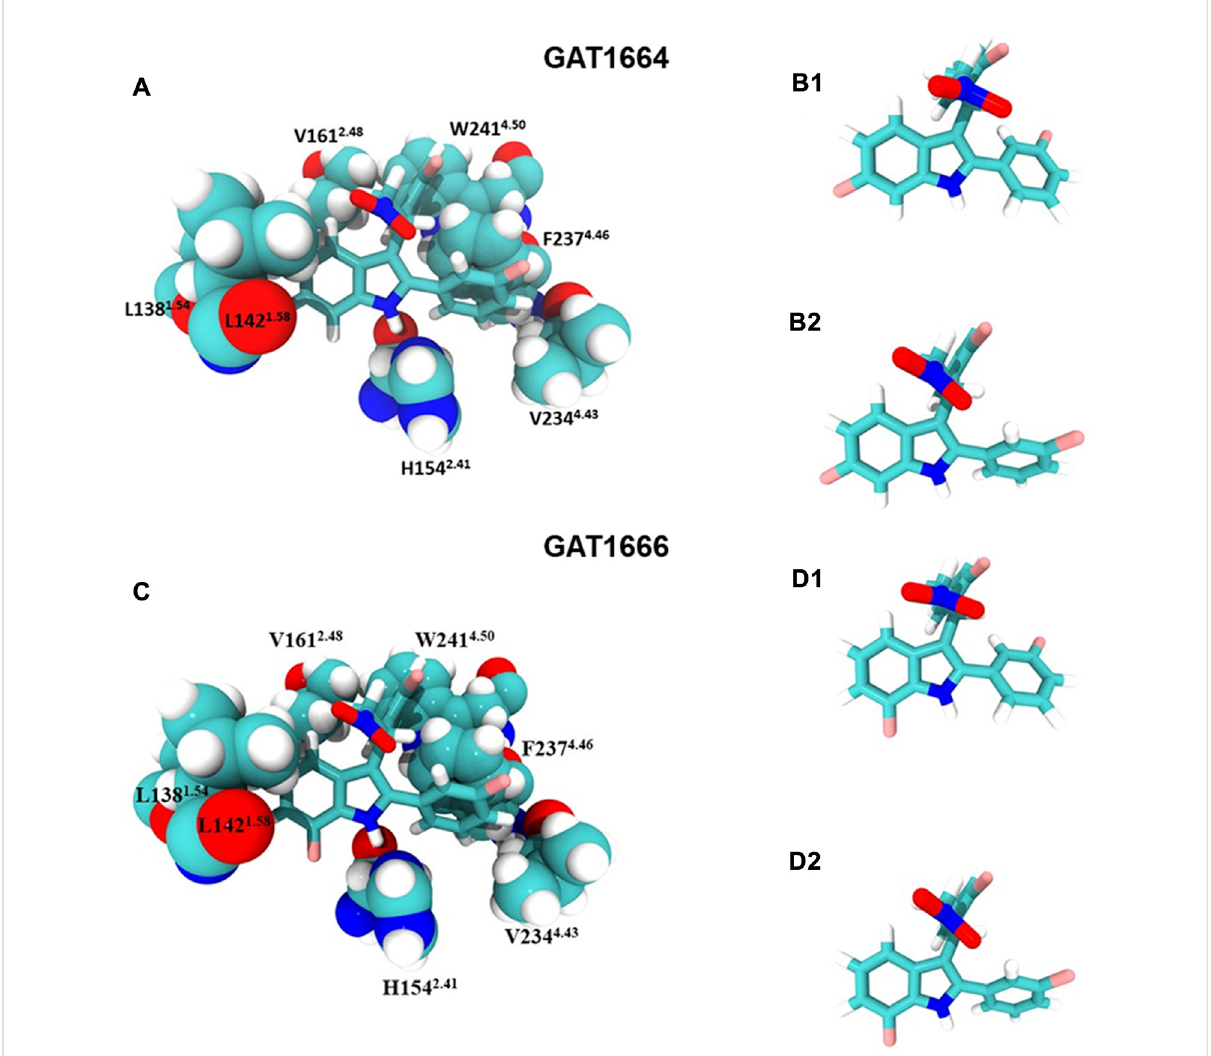
FIGURE 7 GAT1664 and GAT1666 bind to a putative allosteric agonist site. (A) GAT1664 main interactions and the amino acid residues of the binding pocket displayedin tanin Figure 6.The conformation ofGAT1664before itbinds to hCB1R (B1) and then theconformationof GAT1664.afterit binds to hCB1R (B2) . (C) GAT1666 main interactions and the amino acid residues of the binding pocket displayed in tan in Figure 6. The conformation of GAT1666 before it binds to hCB1R (D1) and then the conformation of GAT1664 after it binds to hCB1R (D2)